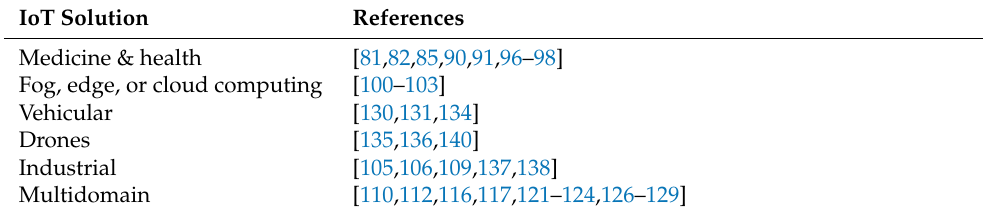
Table 3. The summary of protocol